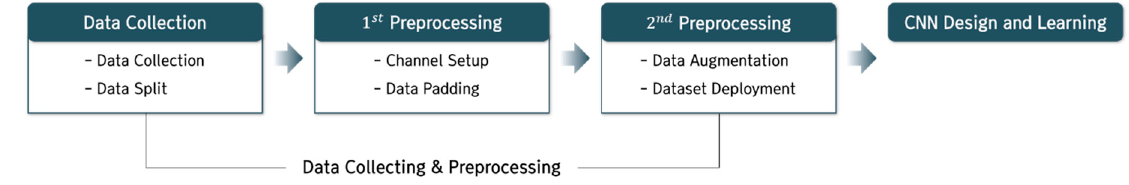
Figure 1. Learning Environment Setting Process.